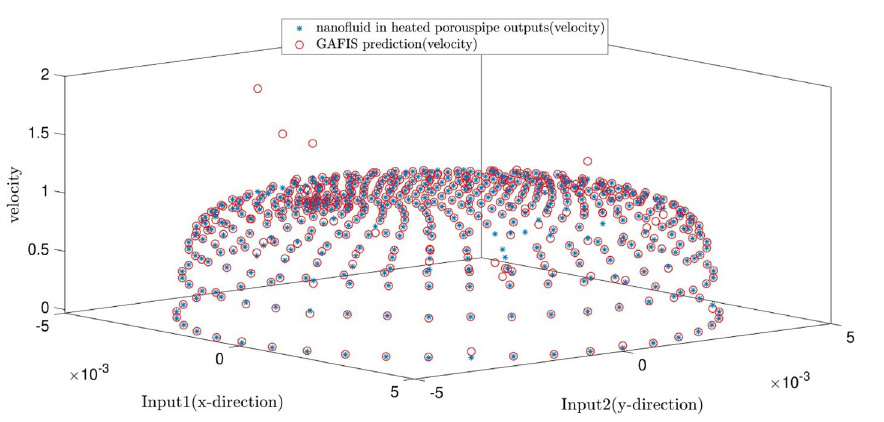
Figure 10. Validation of learning process with comparison of prediction data and CFD